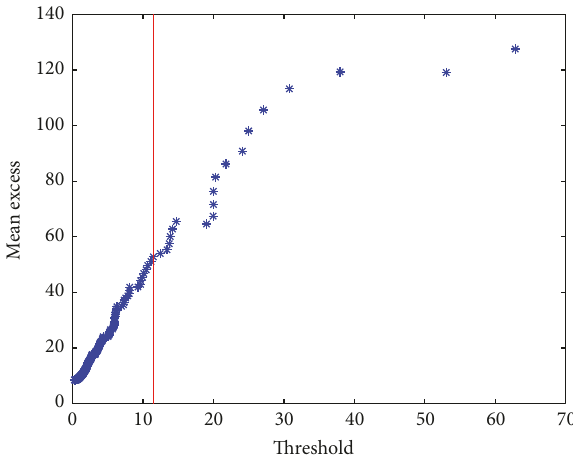
Figure 9: Mean excess plot of the PCS loss index from 2001 to 2010.